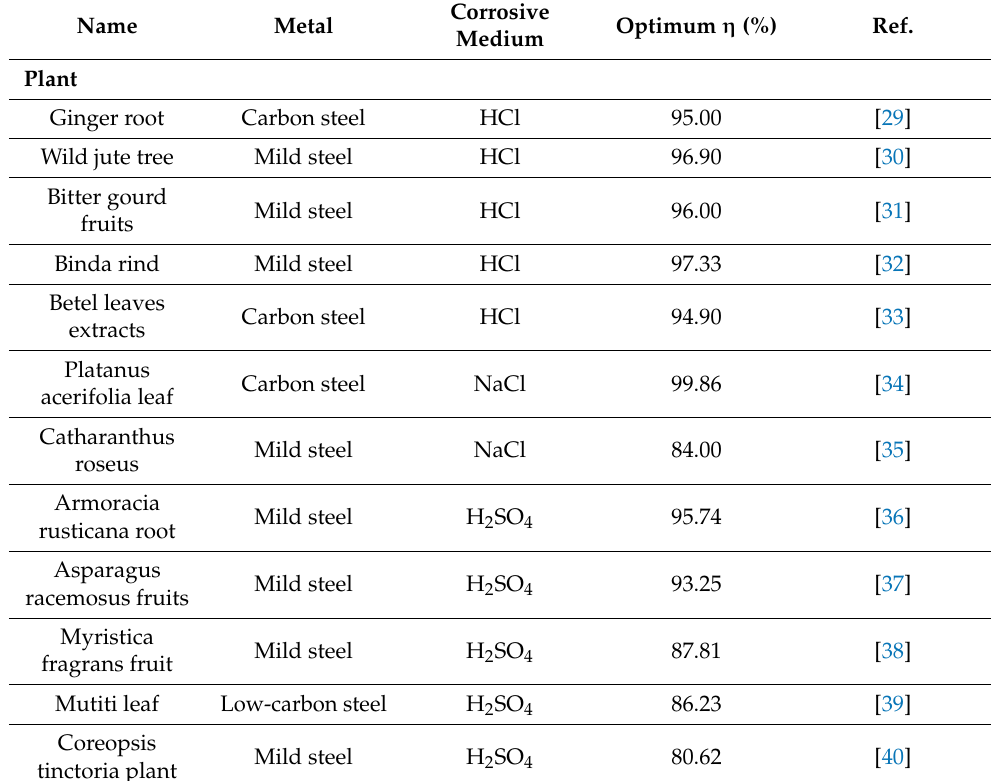
Table 1. The corrosion inhibition performance of different types of corrosion inhibitors in different corrosion